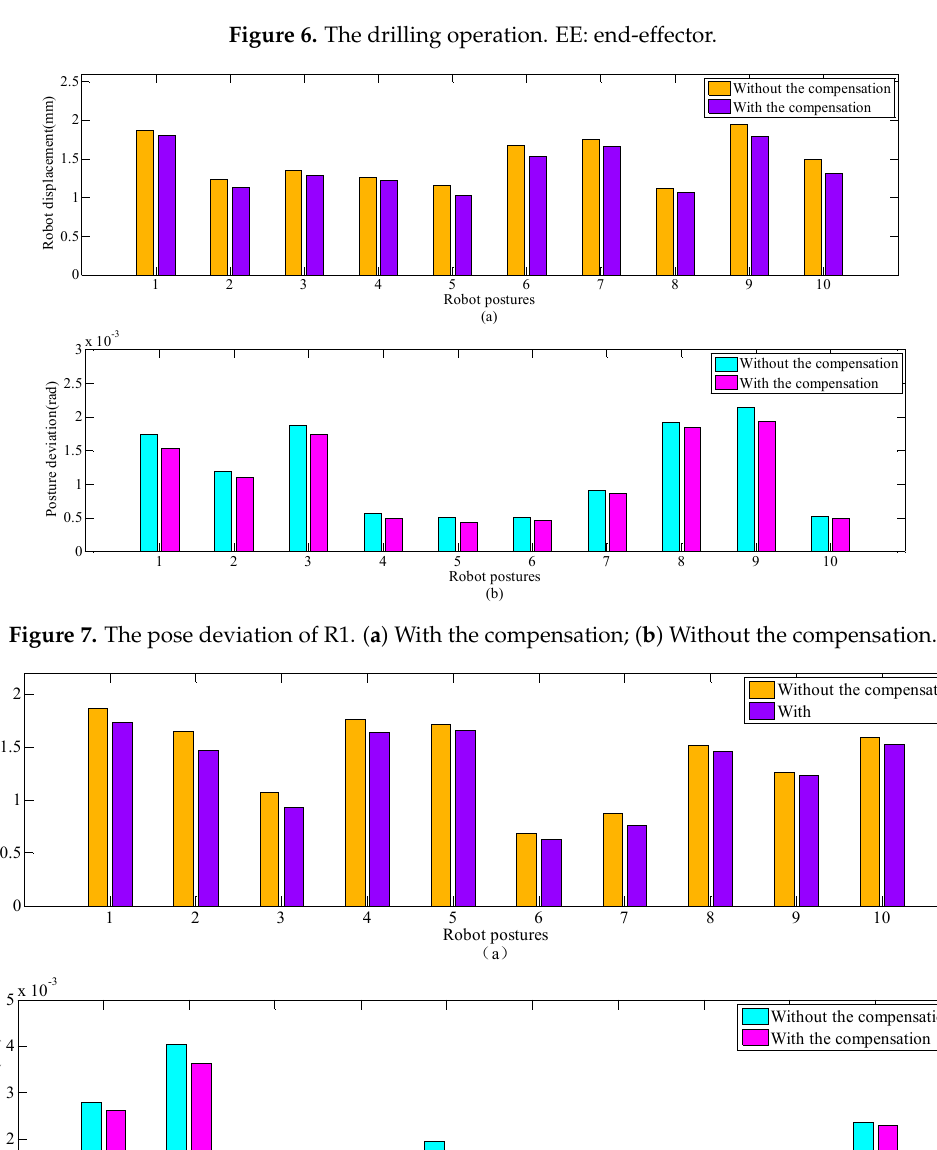
Figure 9. The drop in the pose error of the EE. (a) Drop in the position error; (b) Drop in the orientation error. During the experiment, a carbide drill was used for the procedure, and the drill diameter was 0.5 mm . The circuit board was mounted on the supporting side, which was R1, and the six-axis force sensor 1 measured the supporting forces and torques. The circuit board was 200 mm × 150 mm × 2 mm in size. The target location of the drilling operation was chosen on the circuit board, and the feed rate was set manually. The location was important for the drilling operation, and the pose of the drilling EE was calculated based on the forward kinematic equation mentioned above. In addition, the pose error of the EE and the drill axis direction were important for the performance of the drilling operation, and the deformation compensation was added to the control loop of the robot controller. After the compensation, the location can be chosen precisely. The drill axis direction was perpendicular to the plane of the circuit board. During the drilling operation, the velocity of the drill was set to about 0.001 mm/r manually in order to be a constant element, and the measurement can be concise during the drilling operation as the force sensors have high accuracy. The drilling EE mounted on six-axis force sensor 2 was drilling towards the circuit board, and the z-axis of R1 was parallel to the drill axis direction. Specifically, the drilling EE was moving while the R1 was holding steady during the procedure. The force sensor 2 was measuring the forces and torques during the drilling of the circuit board. The force sensor 1 measured the supporting forces and torques of R1 at the same time. Furthermore, the